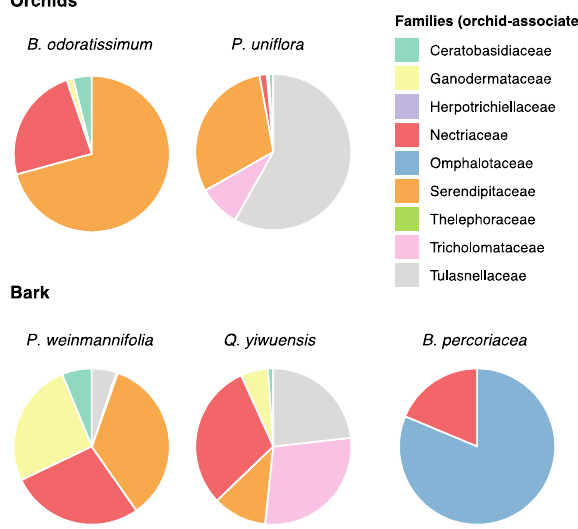
Figure 3. Orchid-associated fungal families detected in orchids and bark samples.